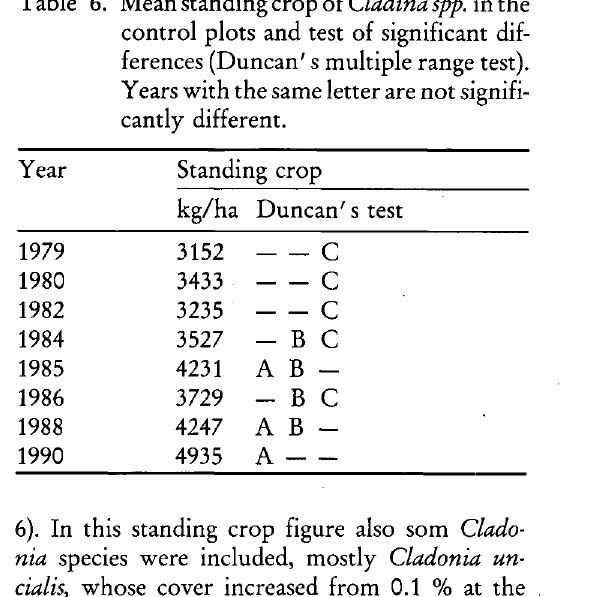
Table 6. Mean standing crop of Cladina spp. in the control plots and test of significant dif ferences (Duncan's multiple range